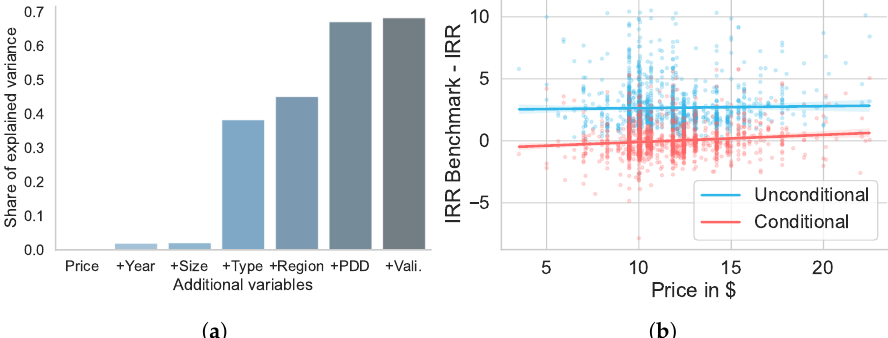
Figure 6. The relationship between climate integrity and project characteristics. ( a ) Explained variation of climate integrity; ( b ) Climate integrity and prices. Notes: Panel ( a ) shows the relationship of ( IRR benchmark − IRR i ) and offset price unconditional and conditional on project type, region and year. Panel ( b ) shows the explained variation of ( IRR benchmark − IRR i ) for major offset characteristics. From left to right, single independent variables are additionally included. Price: CDM price in USD/tCO2; Year: Year dummy credit starts; Type: Project type dummy of the offset project, such as Solar, Reforestation etc.; Region: Region dummy hosting the project: Africa, Europe and Central Asia, Latin America, Asia and Pacific, Middle-East; Size: Expected accumulated ktCO2e of the project; Vali.: Validator dummy, containing the name of the Designated Operational Entity validating; PDD: